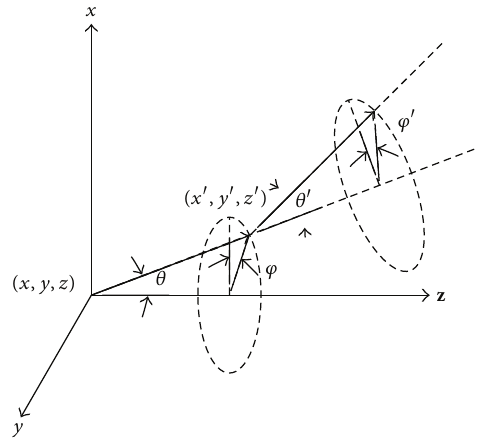
Figure 2: Coordinates of photon